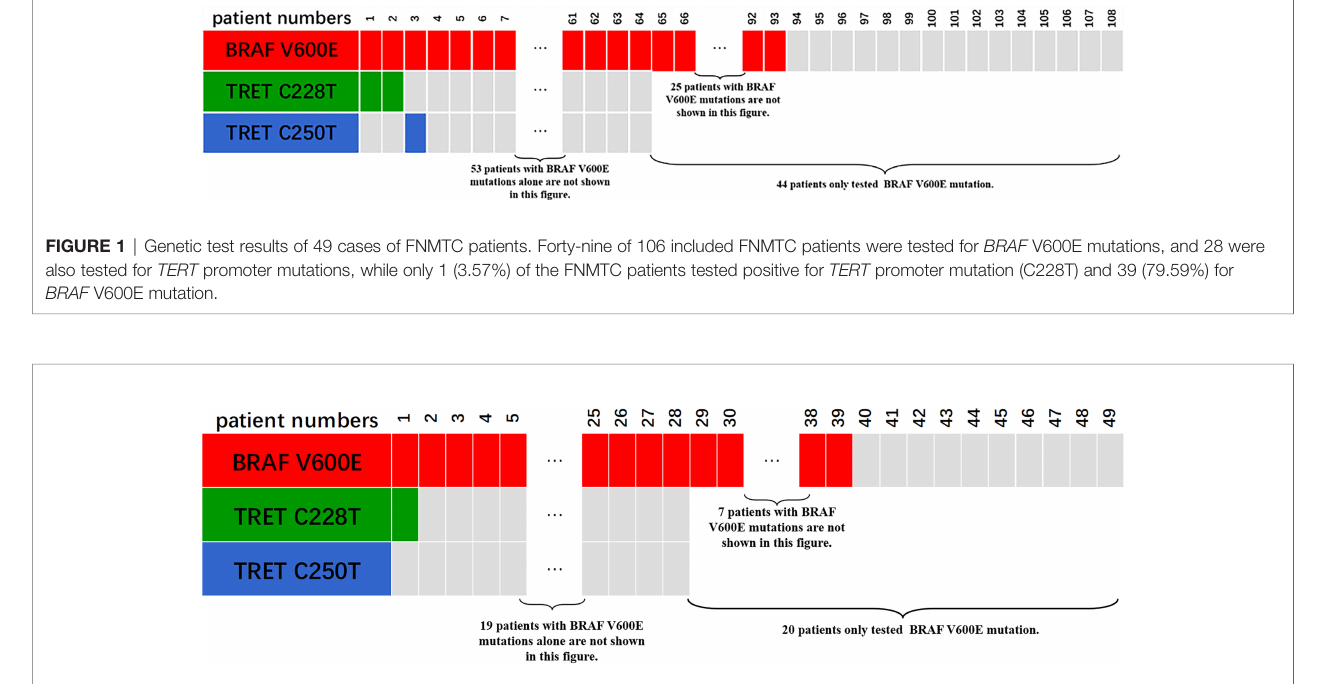
FIGURE 2 | Genetic test results of 108 cases of SNMTC patients. One hundred eight patients were tested for BRAF V600E mutations, and 64 were also tested for TERT promoter in the SNMTC group, while 3 (4.69%) of the SNMTC patients tested positive for TERT promoter mutation (2 were C228T mutations, and 1 was C250T mutation) and 93 (86.11%) for BRAF V600E mutation.